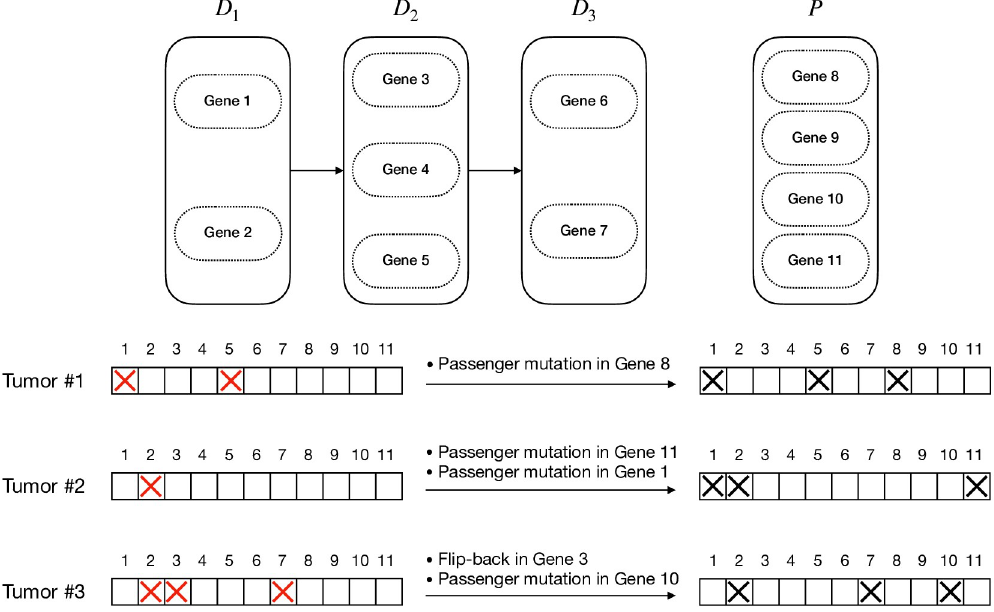
Fig 1. An example of a linear pathway progression model and three tumors generated following the model. The left-hand side gene status bars show the underlying mutational status of the genes with the red cross signs showing the driver mutations. The right-hand side gene status bars show the observed mutation status of genes, where passenger mutations and flip-back events make it hard to infer the true progression model from the observations.